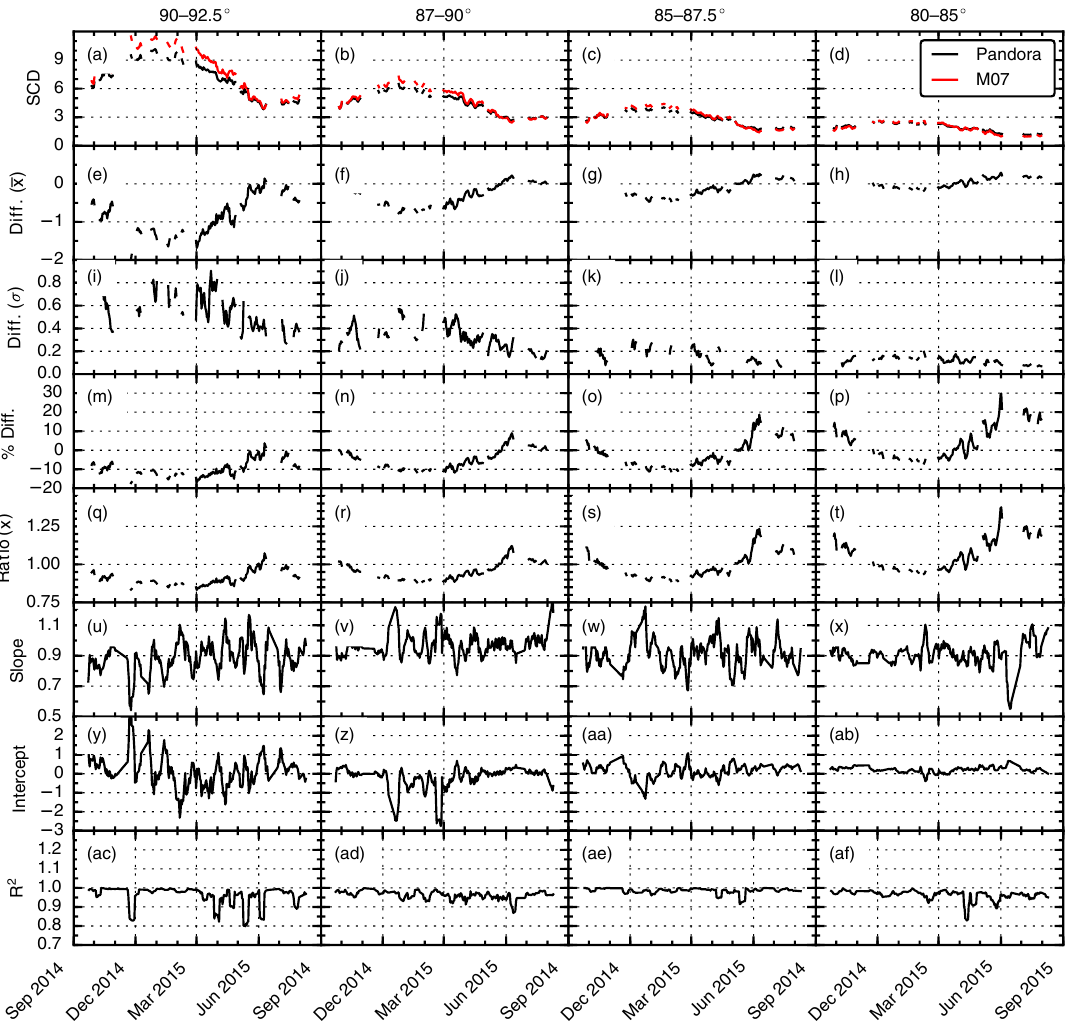
Figure 5. Time series for NO 2 SCD and daily statistics binned by solar-zenith angle. Data were smoothed by a 7-day rolling mean. Panel descriptions: (a–d) SCD for both instruments broken up by SZA; (e–h) mean SCD difference (Pandora – M07); (i–l) standard deviation of differences; (m–p) percent SCD difference; (q–t) SCD ratio (Pandora / M07); (u–x) line of best fit slope (Pandora vs. M07); (y–ab) line of best fit intercept; (ac–af) R 2 coefficient of correlation. A 7-day normally weighted rolling mean was applied to smooth the plots and remove higher-frequency